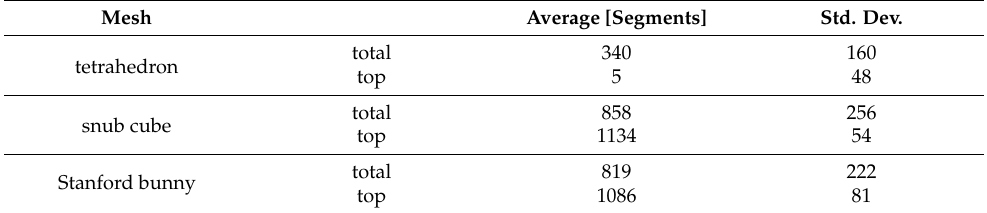
Table 3. Average and standard deviation of total number of helical segments close to mesh for coat- ing